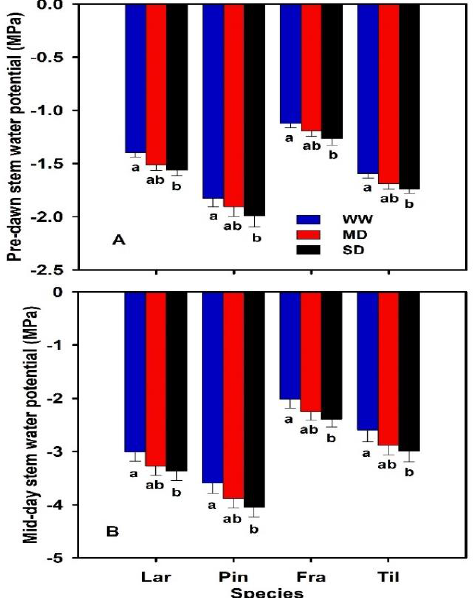
Figure 4. Predawn stem water potential ( Ψ PD ; MPa) ( A ) and midday stem water potential ( Ψ MD ; MPa) ( B ) of two-year-old seedlings of Larix gmelinii (Lar), Pinus koraiensis (Pin), Fraxinus mandshurica (Fra), and Tilia amurensis (Til) at three drought levels (i.e., severe drought, SD, ≤ 5%; moderate drought, MD, 6 – 10%; well-watered, WW, 16 – 20%). Within species, significant differences between treatments are indicated by different lower- case letters (Tukey’s HSD post hoc; p < 0.05; mean ± SE). Table 2. Anatomical traits of mature, sun-exposed needles/leaves of two-year-old seedlings of Larix gmelinii , Pinus koraiensis (gymnosperms), Fraxinus mandshurica , and Tilia amurensis (angiosperms), at three drought levels i.e. severe drought, SD, ≤5%; mo derate drought, MD, 6 – 10%; well-watered, WW, 16 – 20% in NE China.